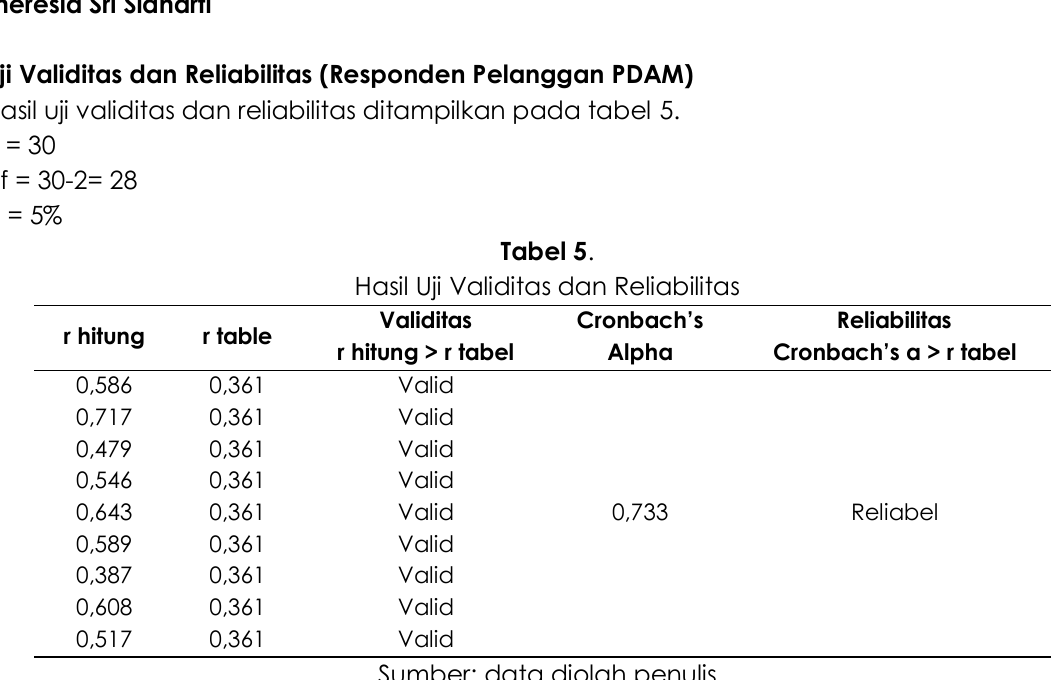
Tabel 5 tersebut menunjukkan item-item tersebut valid dan reliabel. Sehingga kuesioner pada penelitian ini dinyatakan valid dan konsisten ( reliable ).